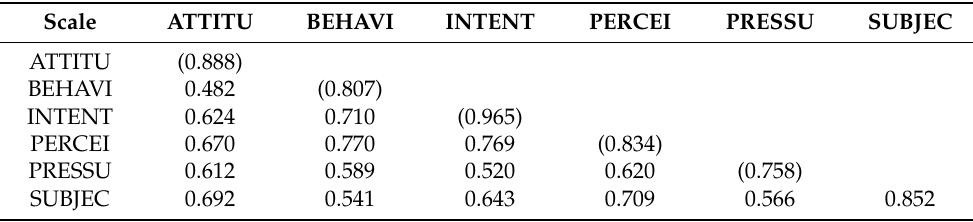
Table 2. Discriminant validity of sub-scales using the Fornell–Larcker criterion.